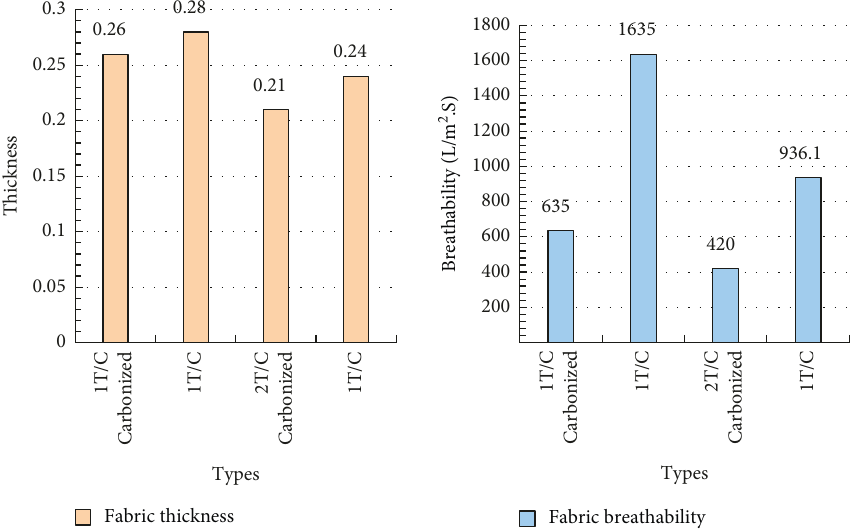
Figure 7: Effect of carbonization on the thickness and air permeability of blended